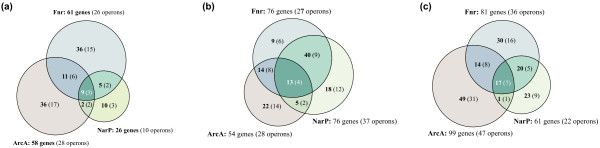
Regulogs composition in three families. (a) Enterobacteriaceae (Yersinia spp.); (b) Pasteurellaceae; (c) Vibrionaceae. The numbers of genes and operons in parentheses predicted to belong to the regulogs are shown.